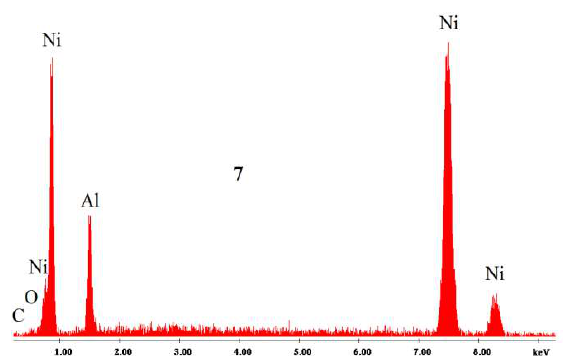
Figure 14. SEM of cross-section and EDX analysis of points 1–7 of nickel aluminide coating (COATR 7) after cyclic polarization in 3.5 wt.% NaCl at 25 °C. ( a ) low magnification for a general view, ( b ) magnification of the “square area” of ( a ), ( c ) magnification of the “square” area of ( b ), ( d ) area below the crevice of ( c ), ( 1 – 7 )—EDX spectra of respective points in ( c ) and ( d ).